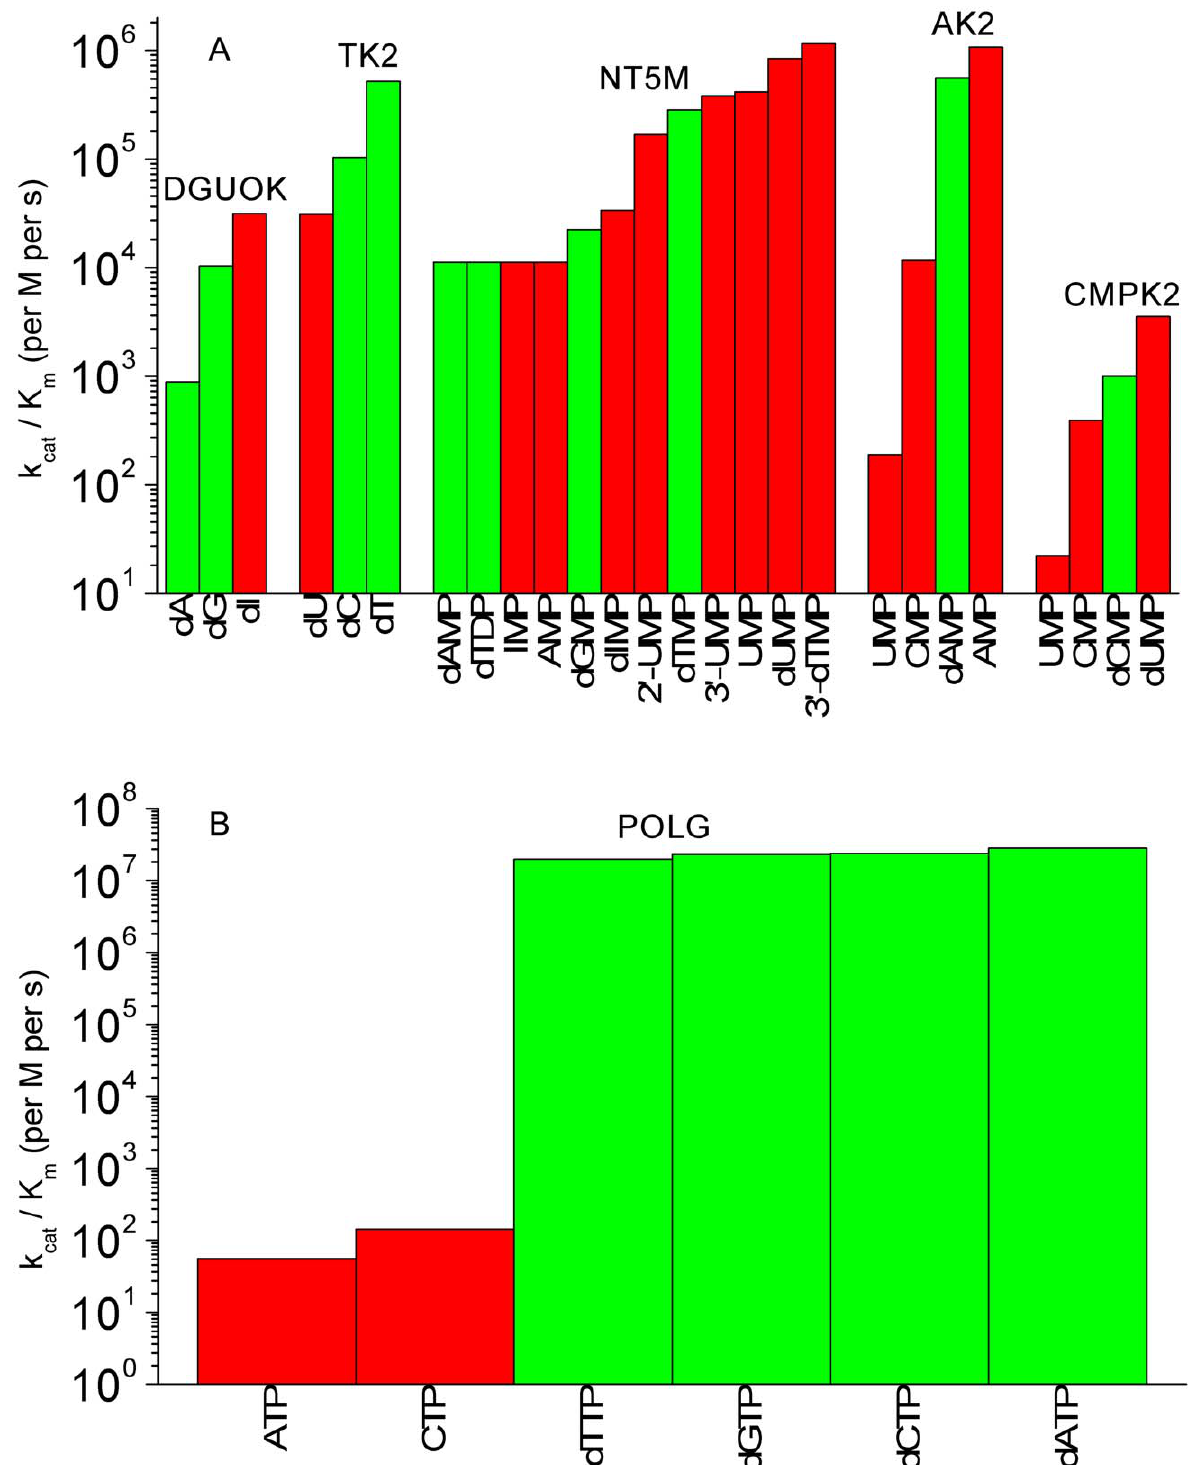
Figure 2. k cat /K m values of mitochondrial enzymes. ( A ) k cat /K m values of mitochondrial salvage enzymes. Each group of bars is for one enzyme, and within each such group the bars are arranged from lowest to highest so that the best substrates lie to the right on each plot. Substrates that are DNA precursors are in green, and non-DNA precursor substrates are in red. 2 9 -UMP and 3 9 -UMP refer to uridine 2 9 monophosphate and uridine 3 9 monophosphate. ( B ) k cat /K m values of the mitochondrial DNA polymerase POLG, justifying the use of k cat /K m as a measure of substrate preference.